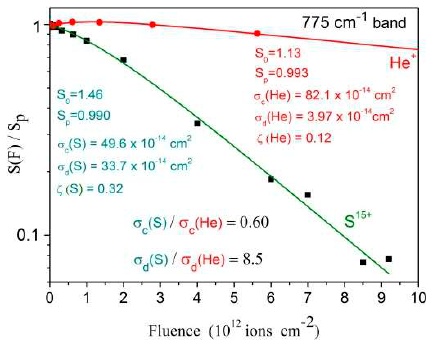
Figure 10. Integrated absorbance decrease for the 775 cm − 1 band as a function of fluence for the 1.5 MeV He + and the 230 MeV S 15 + beams. Fittings are performed with Equations (7) and (8) (Section 4.2). Table 3 offers an overview of the measured apparent destruction cross sections for the all the ion beams, based on five selected bands; as illustration, one extra band (782–763 cm − 1 ) was analyzed for the He + and S 15+ ion beams to extract σ c . The conclusion, already anticipated by the results exhibited